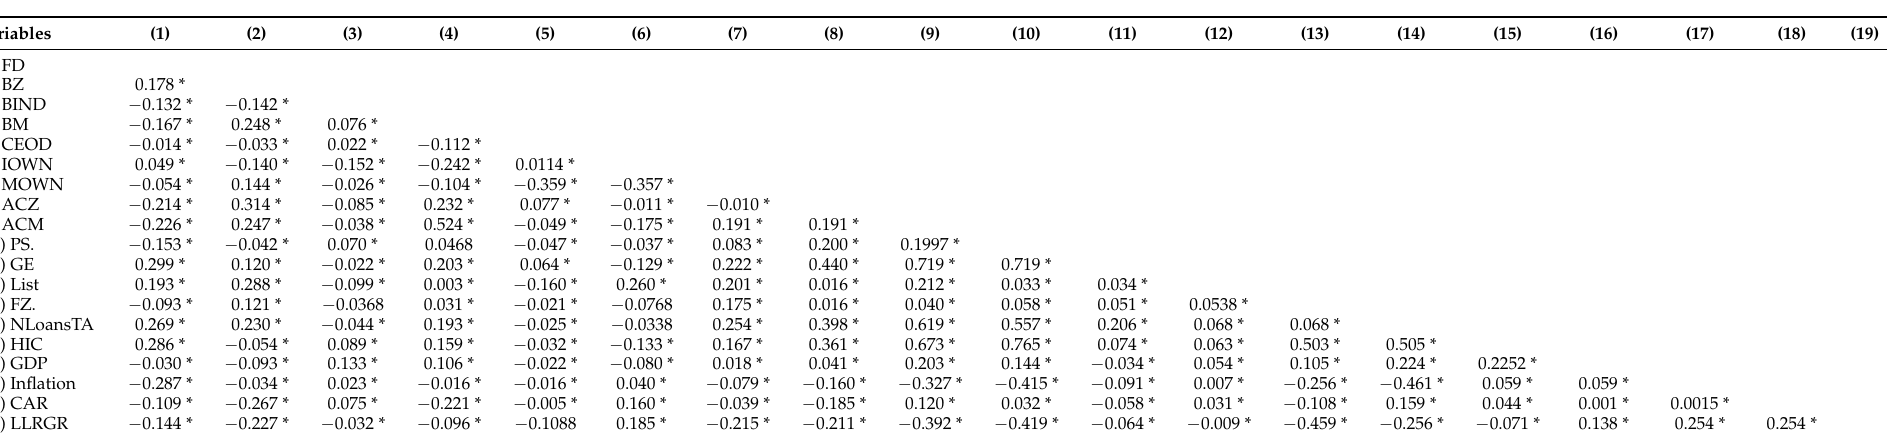
Table 4. Pearson pairwise correlation matrix: full